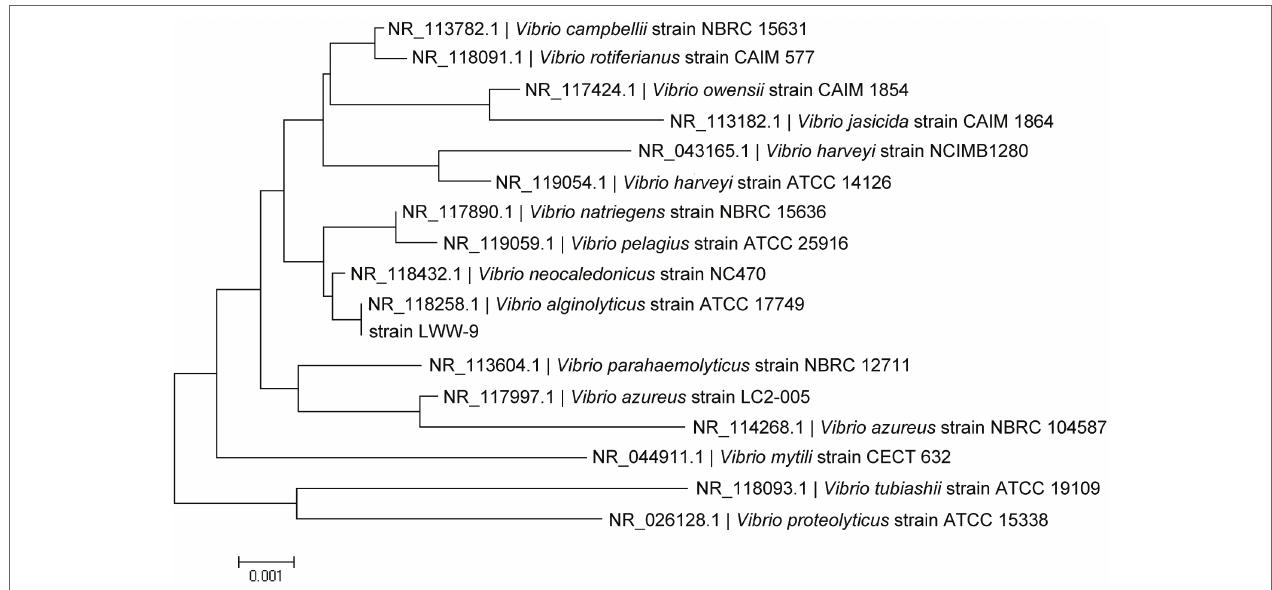
FIGURE 1 | Phylogenetic tree of strain LWW-9 based on 16S rRNA sequences. The phylogenetic tree was generated by MEGA X using the neighbor-joining